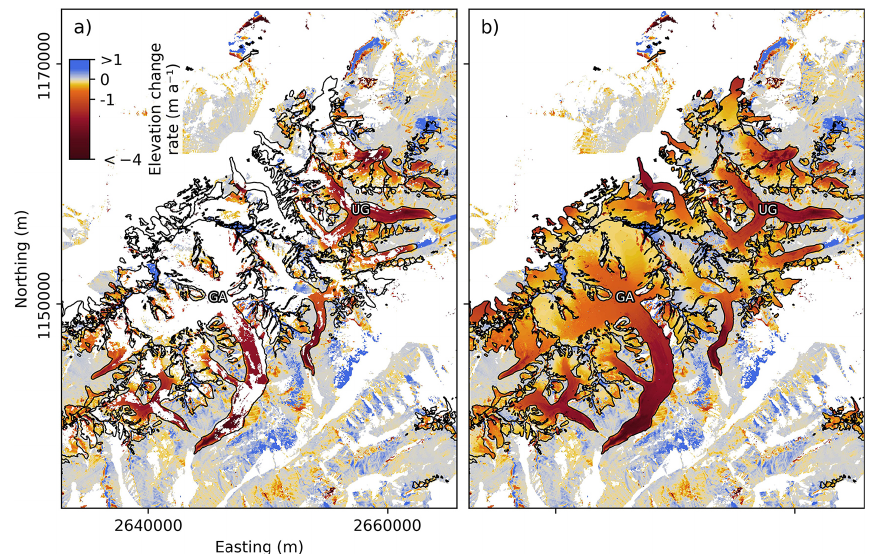
Figure 6. Maps of average ice thickness change rates (d H d t − 1 ) over the period 1931–2016 before (a) and after (b) interpolation. The area shows Grosser Aletschgletscher (GA; alternatively Great Aletsch Glacier), Unteraargletscher (UG), and other neighbouring glaciers. Glacier outlines from ca. 1931 are drawn in